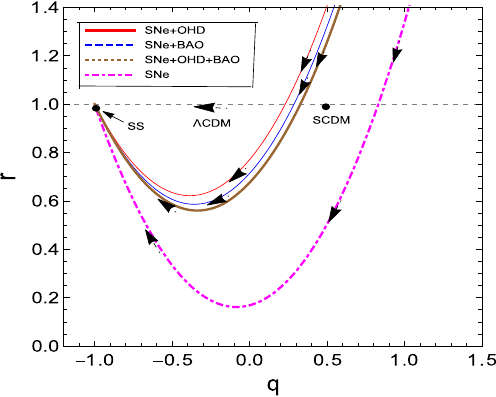
Fig. 8 The age of universe as a function of redshift for best-fit values of model parameters